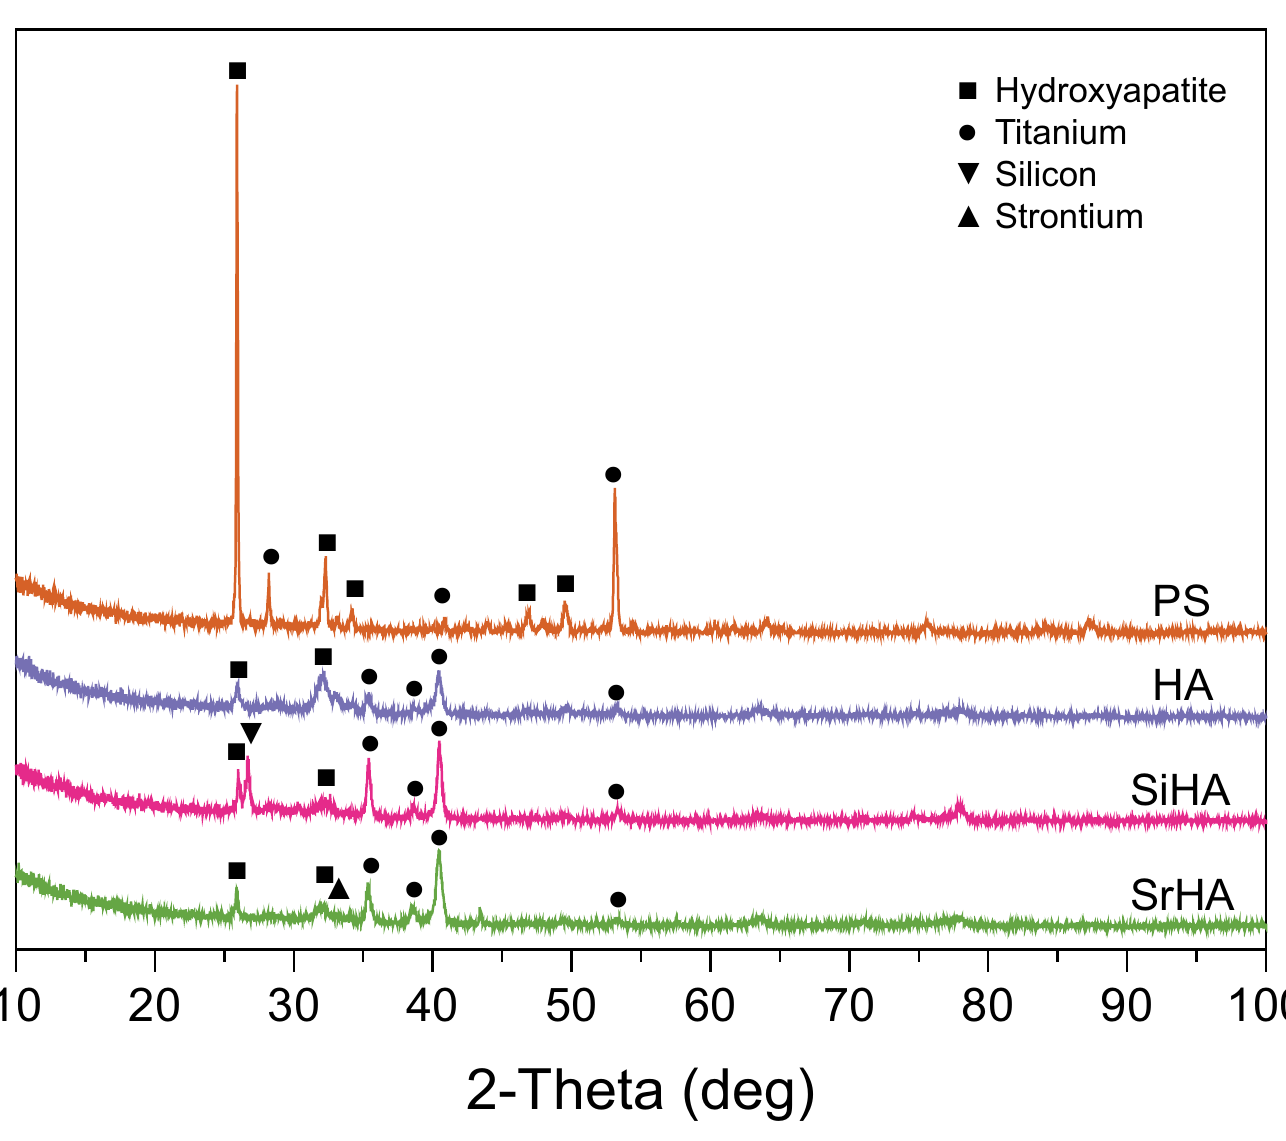
Fig 3. XRD spectra of the coatings on Ti6Al4V structures. PS, plasma sprayed HA; HA, electrochemical HA; SiHA, electrochemical SiHA; SrHA, electrochemical SrHA. ■ ,•, ▼ and ▲ on spectra denote HA, Titanium, Silicon and Strontium peaks respectively.